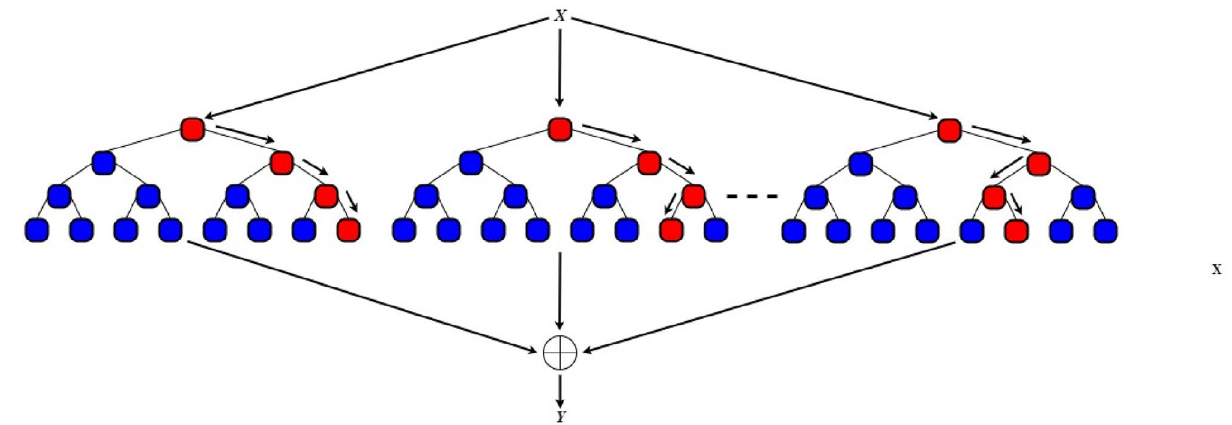
Figure 1. Sample of a random forest